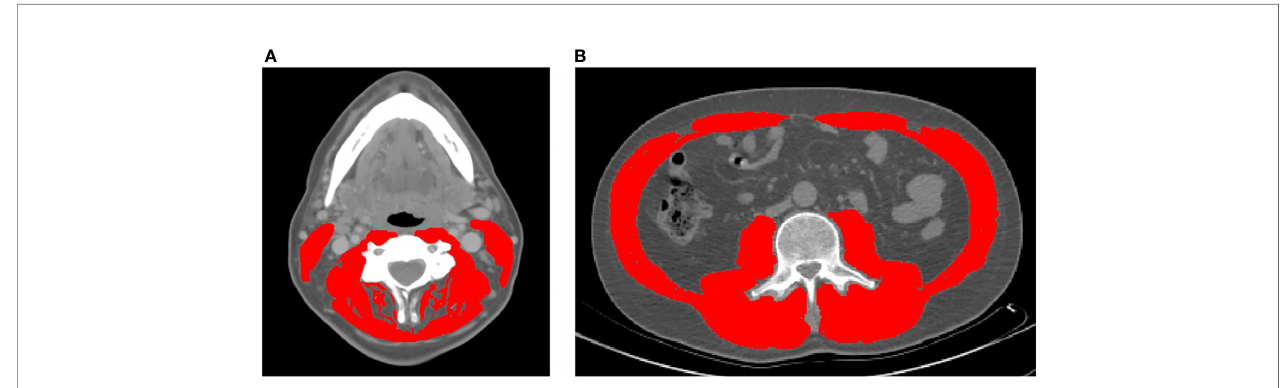
FIGURE 1 | Representative axial CT images of the third cervical (A) and third lumbar (B) vertebral levels used to quantify skeletal muscle index (highlighted in